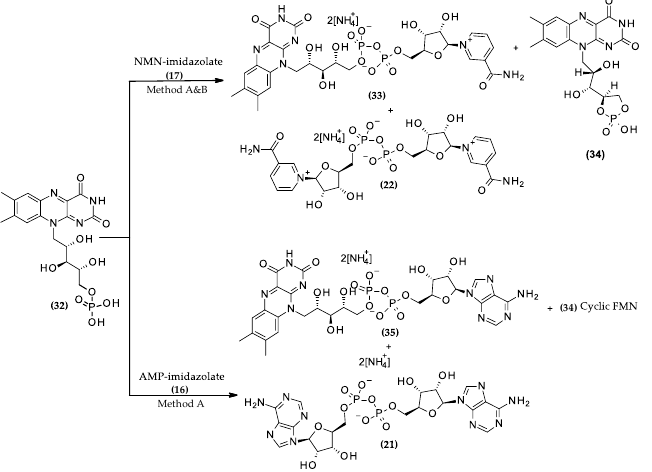
Scheme 4. Synthesis of flavin-nicotinamide dinucleotide ( 33 ), flavin-adenine dinucleotide (FAD) ( 35 ) and cyclic-FMN ( 34